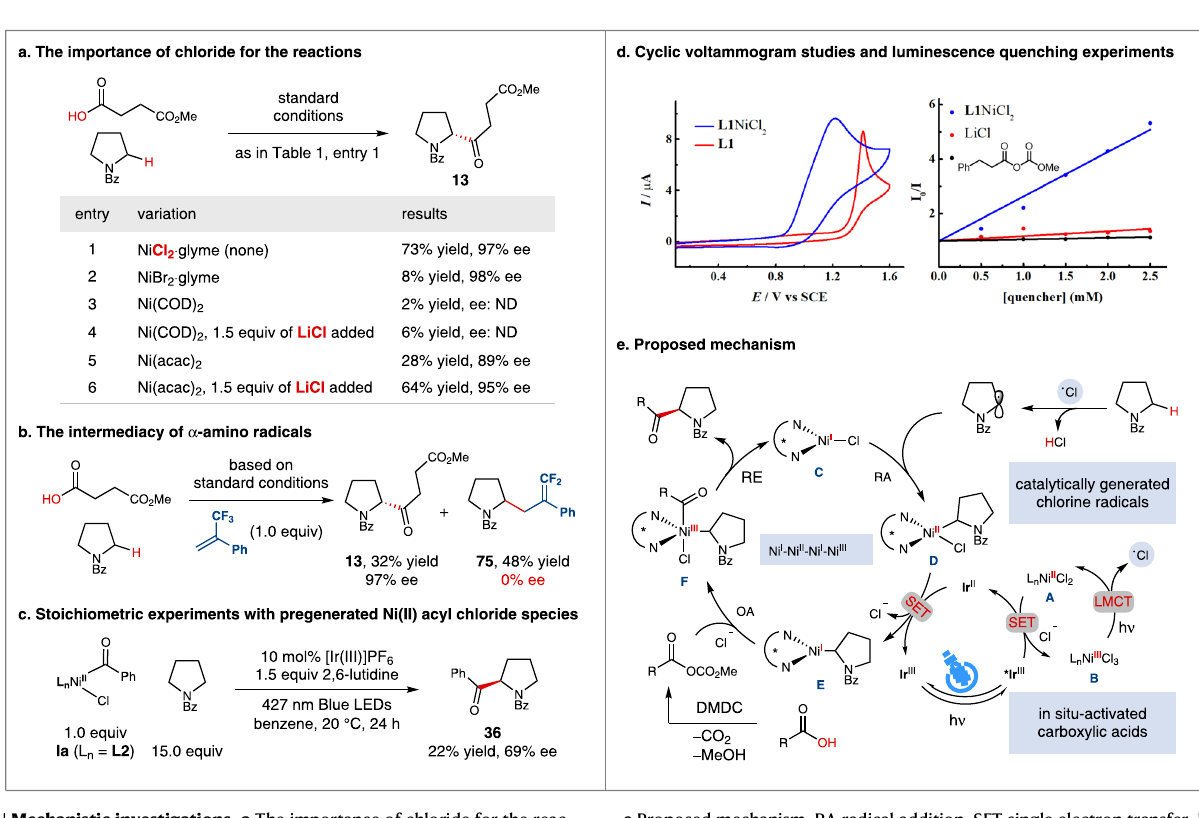
Fig. 5 | Mechanistic investigations. a The importance of chloride for the reac- tions. b The intermediacy of α -amino radicals. c Stoichiometric experiments. d Cyclic voltammogram studies and luminescence quenching experiments.